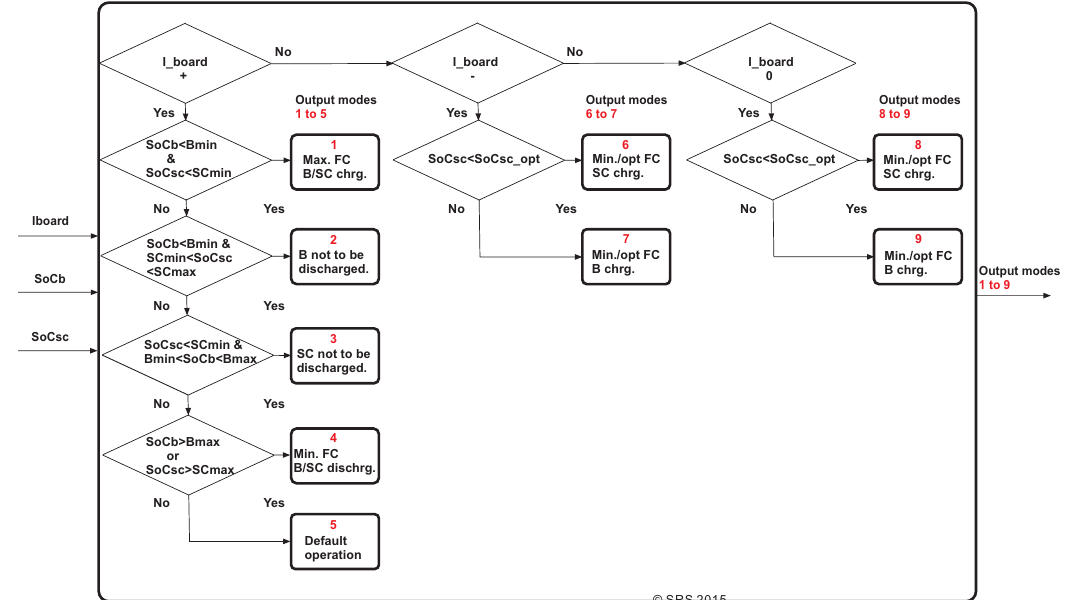
Figure 16. Details of the mode selection block. Fuel cell, battery, and supercapacitor are represented by FC, SC, and B respectively. Charging is defined by chrg. and optimal by